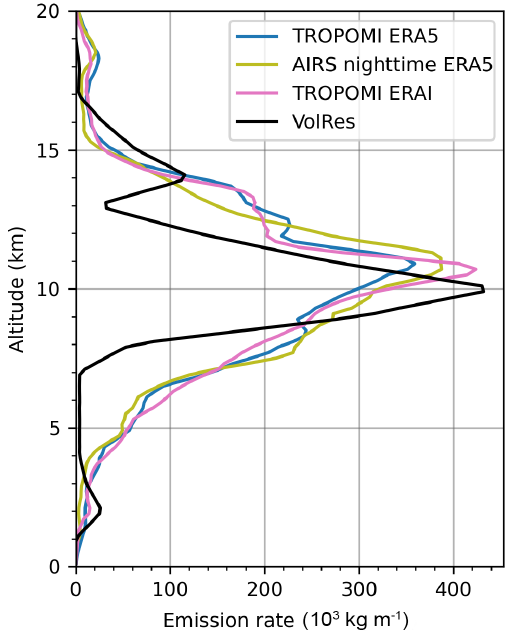
Figure 4. Vertical profiles of Raikoke SO 2 injections derived by the VolRes team and from different combinations of datasets (see plot legend).